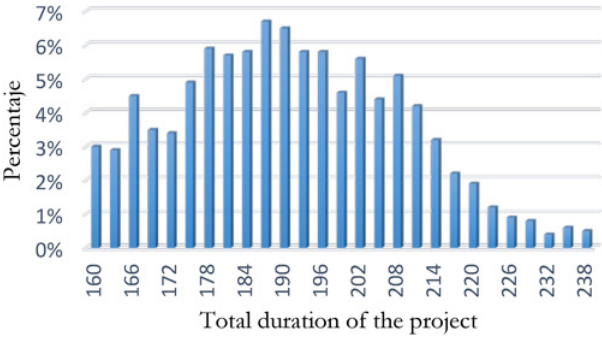
Probability distribution of the duration of the project completion, experiment